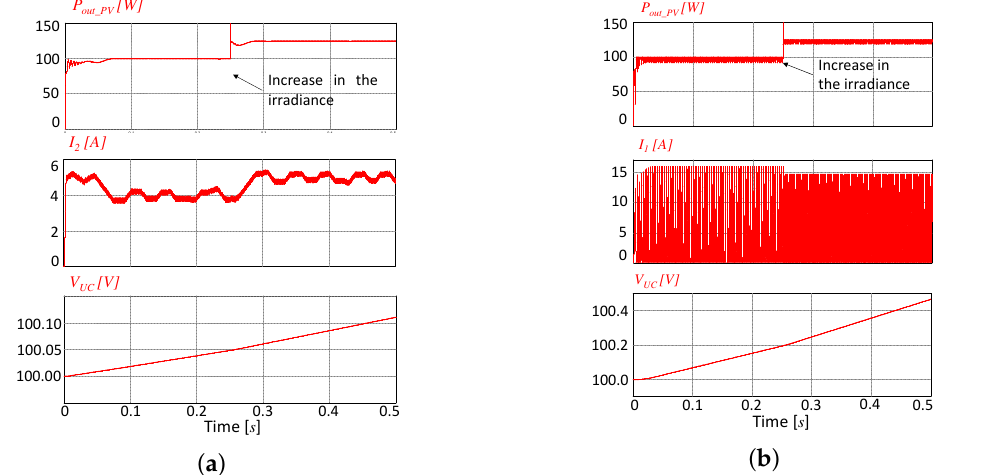
Figure 15. Methods implemented to achieve the MPPT of the PV, ( a ) utilizing the multiple-input converter and manipulating the reference of the current I 2 , ( b ) manipulating the switches S UC and S 1